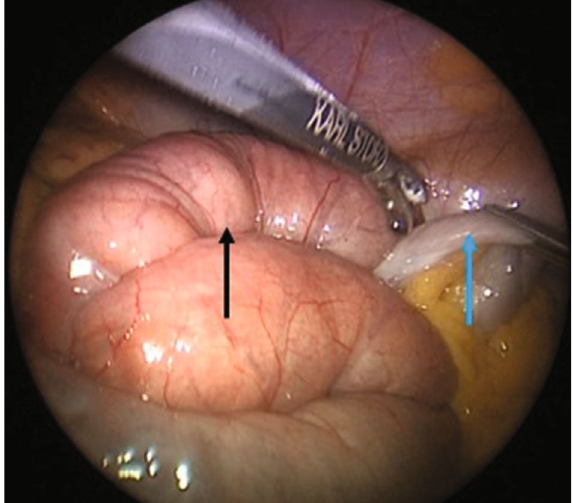
Figure 4: Diagnostic laparoscopy showing collapsed distal jejunal loops (blue arrow) and dilated proximal loops (black